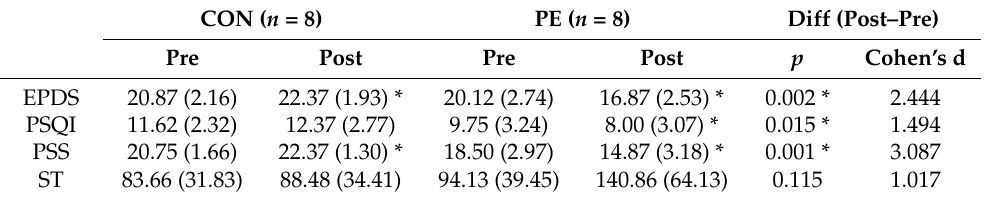
Table 5. Psychological effects.